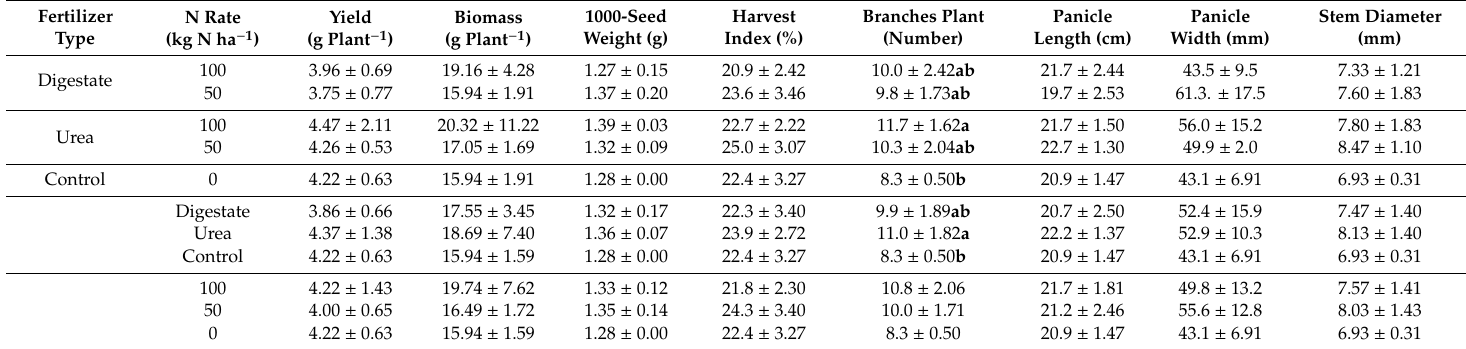
Table 4. ANOVA ( ± SD) and Fisher test for di ff erent crop parameters and N fertilization treatments (100 / 50 kg N ha − 1 urea, 100 / 50 kg N ha − 1 digestate, and 0 kg N ha − 1